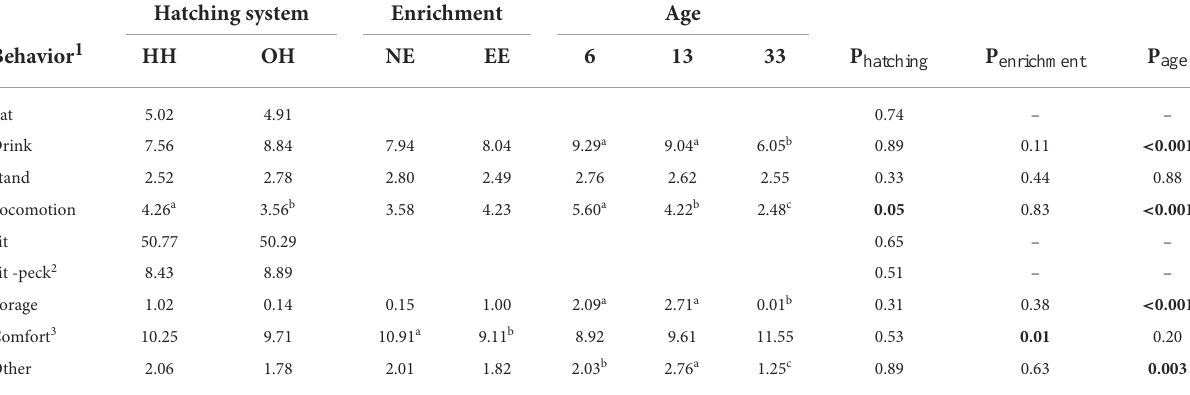
TABLE 3 Proportion of chickens performing the different behaviors (back-transformed means) and P -values for hatching conditions (HH, hatchery-hatched; OH, on-farm hatched), enrichment (NE, no brooder; EE, dark brooder until 14 days of age), and age. Significant effects are indicated in